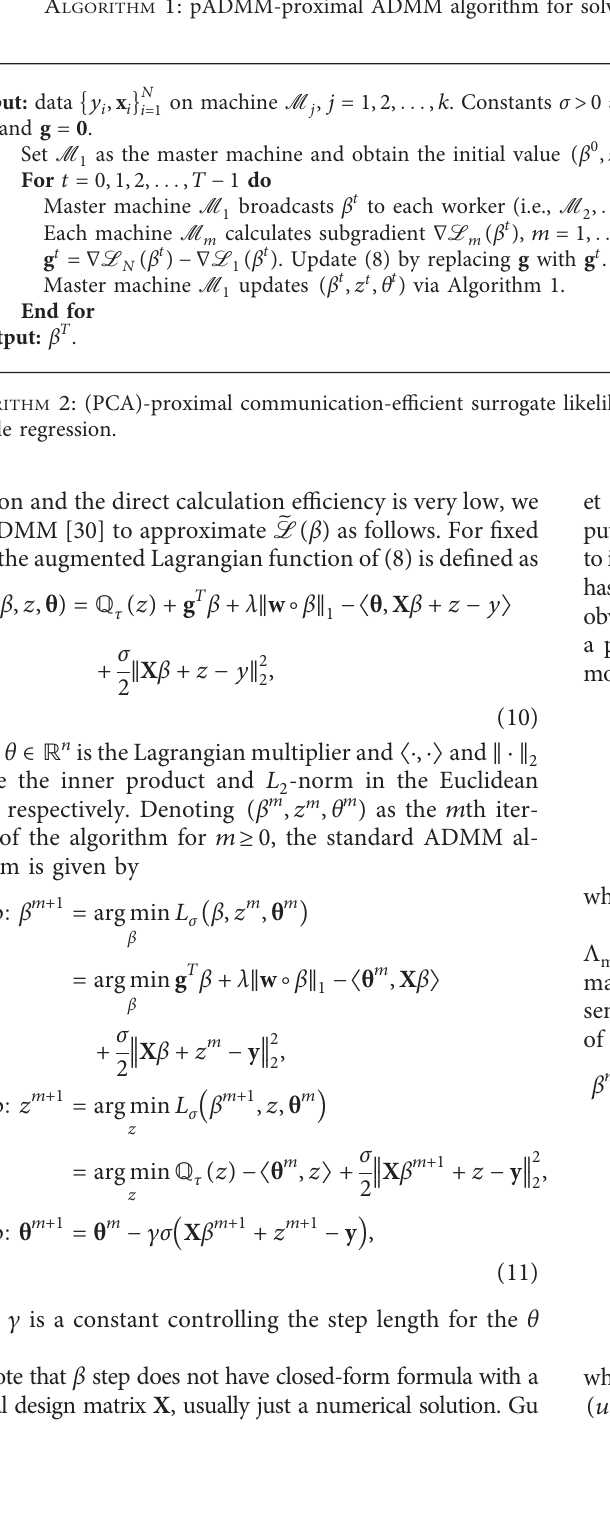
A LGORITHM 1: pADMM-proximal ADMM algorithm for solving the weighted L